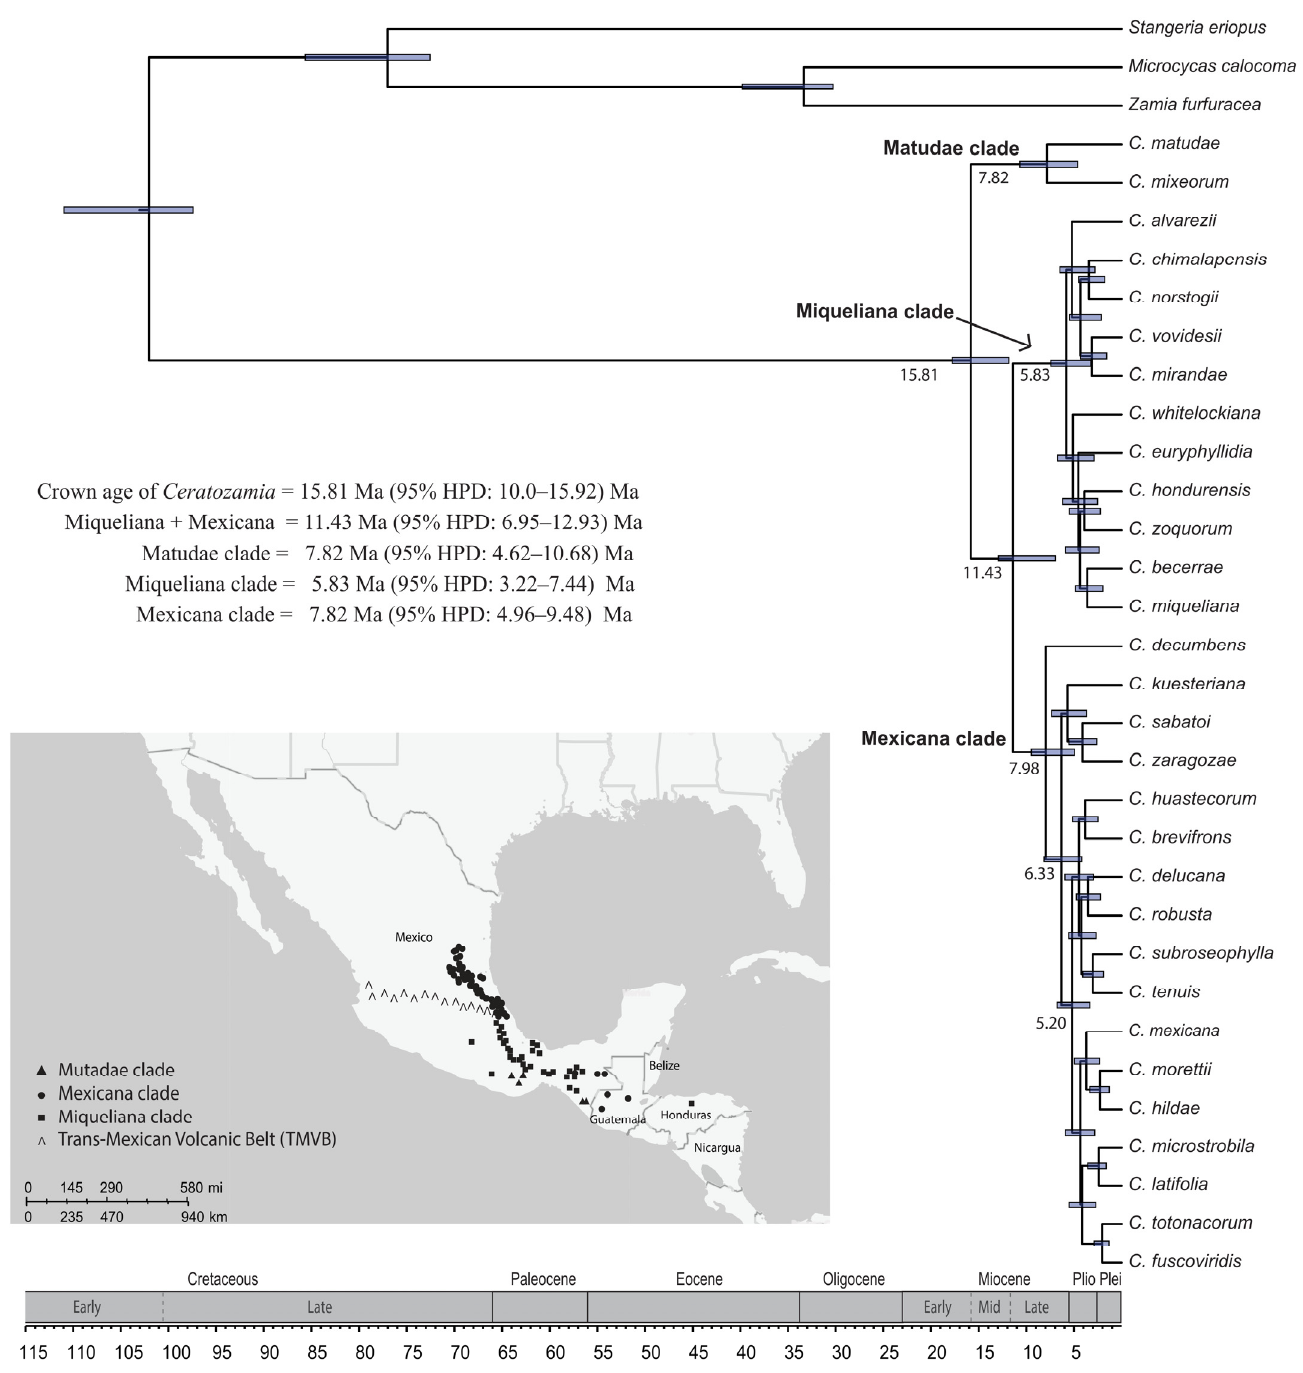
Figure 4. Chronogram for Ceratozamia reconstructed based on the combined data matrix of 50 SCGs constrained to the ML tree of the concatenated dataset with all codon positions included (nt dataset). Node bar on each node represents the minimum and maximum ranges of dates from both low and high calibration. The map shows the geographical extents of the three major clades among the three distinct areas of its distribution in Mexico and its adjacent regions.